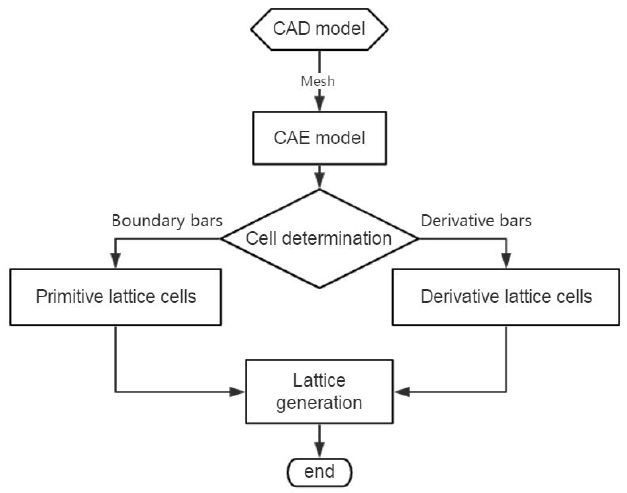
Figure 2. Flowchart of the lattice structure modeling method based upon finite element mesh.